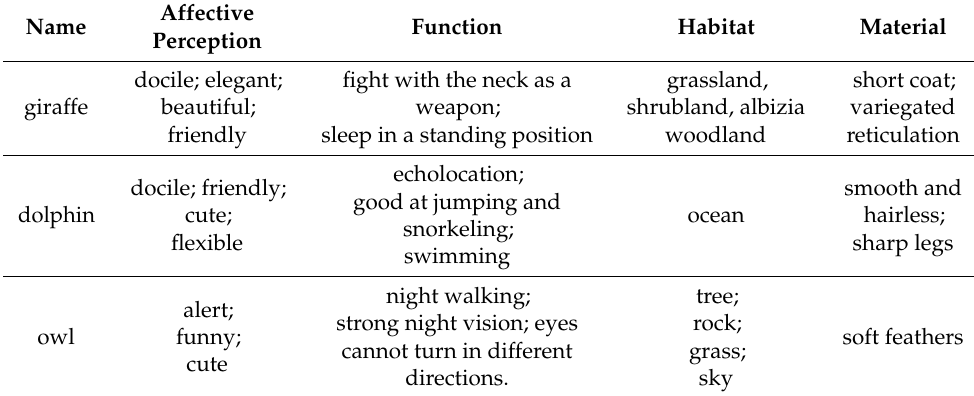
Table 11. Biological description dataset (display part of data).